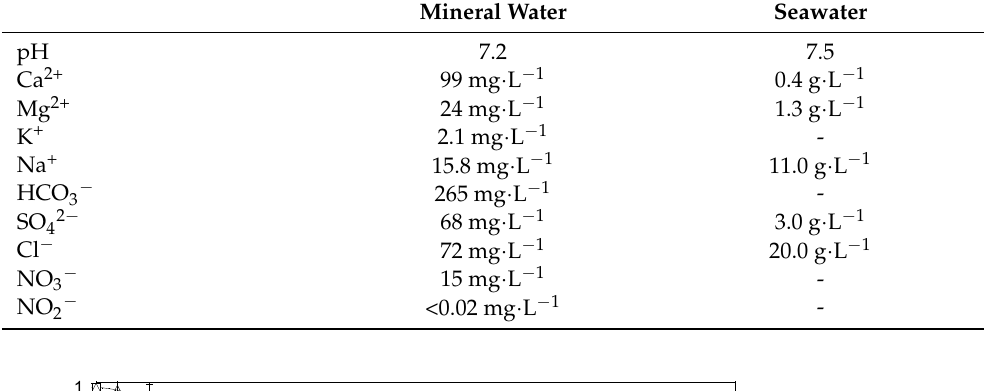
Table 3. Principal characteristics of water matrices used in this study.